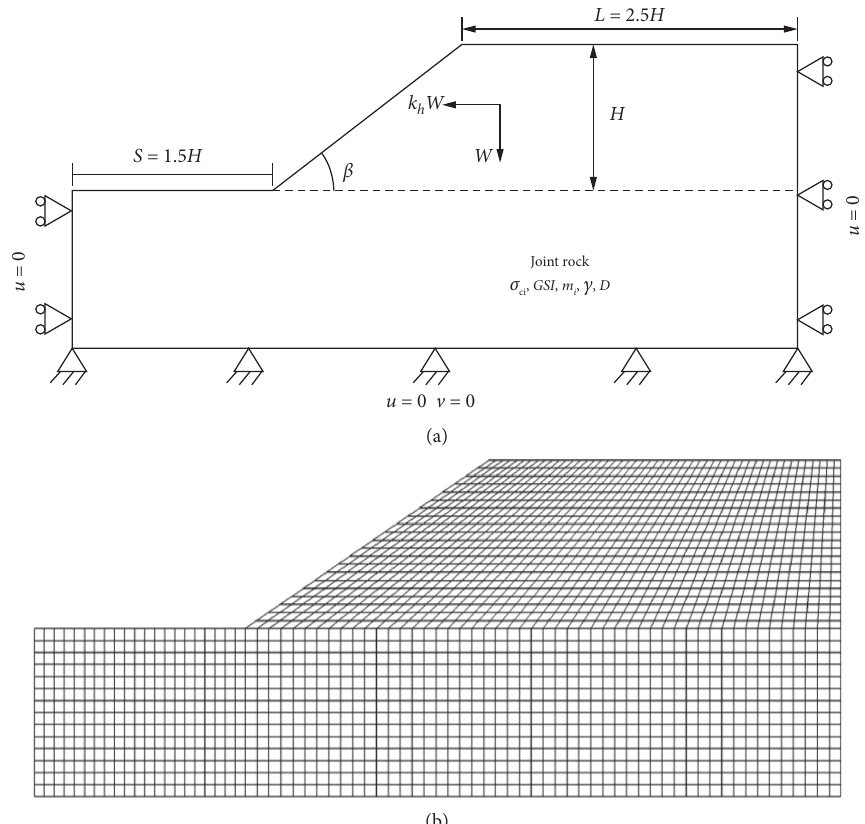
Figure 5: Sketch of definition for pseudostatic stability analysis of rock slope in this paper: (a) typical slope model and the boundary conditions; (b) mesh of the slope